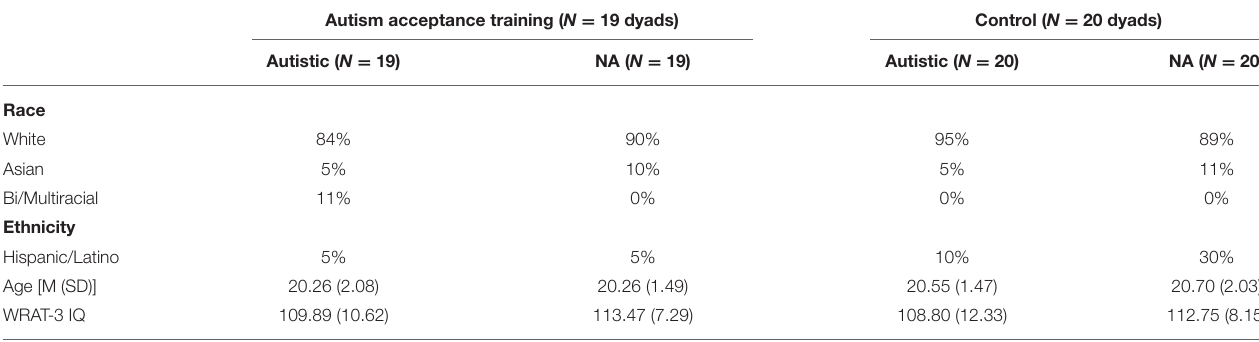
TABLE 1 | Participant demographics by training condition and